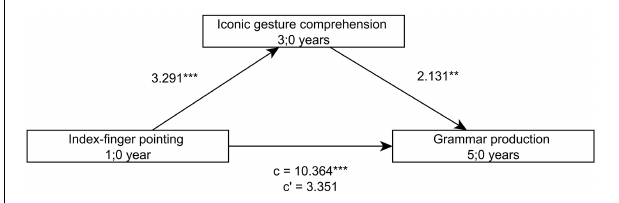
FIGURE 4 | Model of index-finger pointing at 1;0 as a predictor of productive grammar skills at 5;0, mediated by iconic gesture comprehension at 3;0.